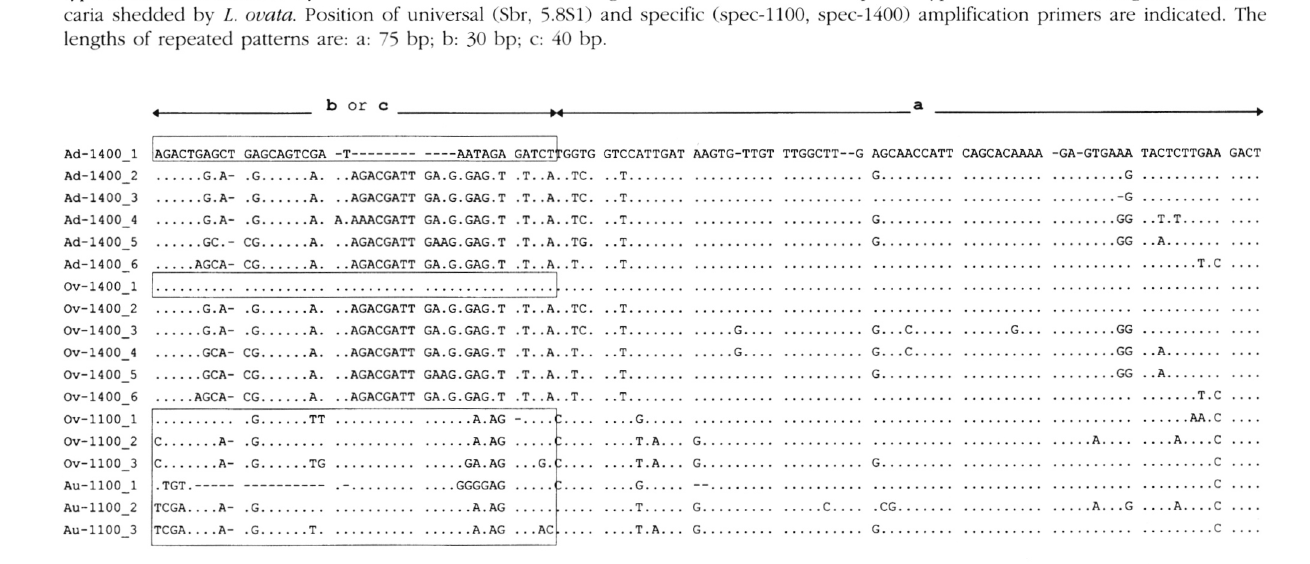
Fig. 1. - Schematic representation of the ITS1 ribosomal DNA types of analysed material, auricularia -1100 and ovata- 1100: 1100 bp ITS1 type of cercariae shedded by L. auricularia and L. ovata ; T. regenti and ovata- 1400: 1400 bp ITS1 type of an adult of T. regenti and a cer­